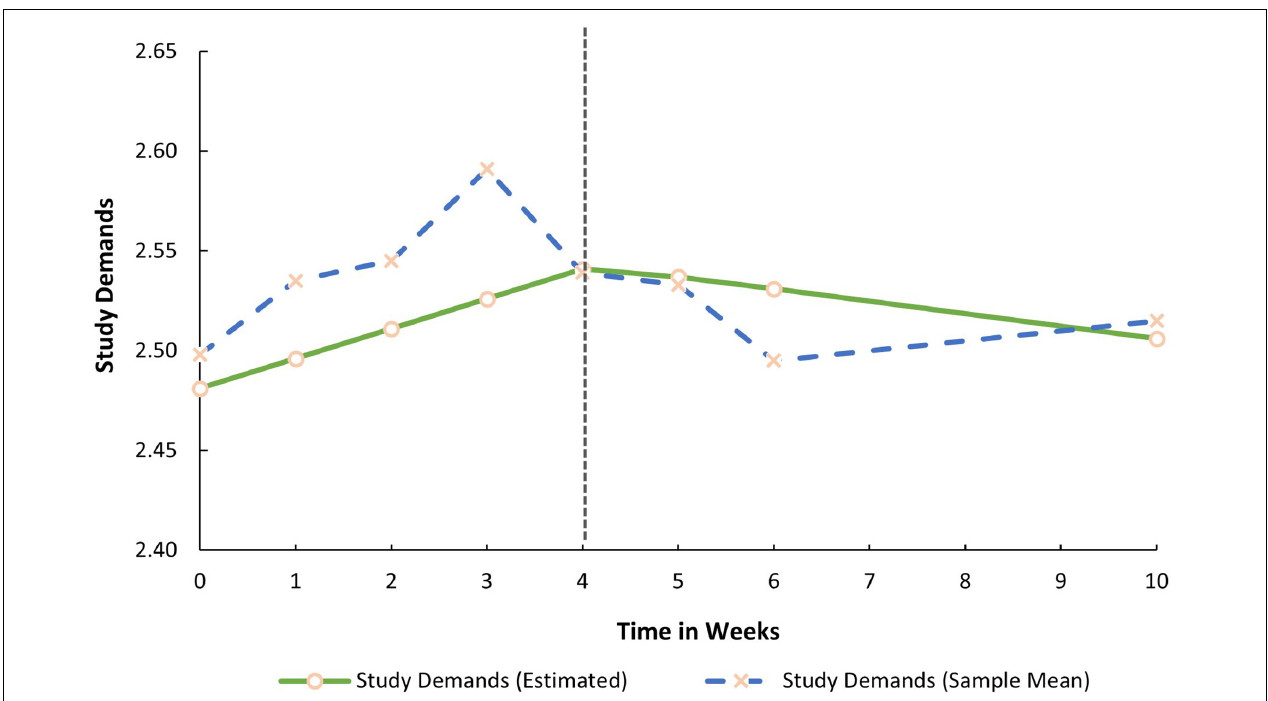
FIGURE 2 | Estimated trajectory of study demands before and during the COVID-19 lockdown.